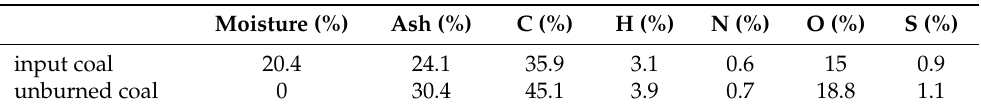
Figure 3. Physical coal seam model for the ( a ) experiment #1, ( b ) experiment #2, ( c ) experiments #3 and #4.